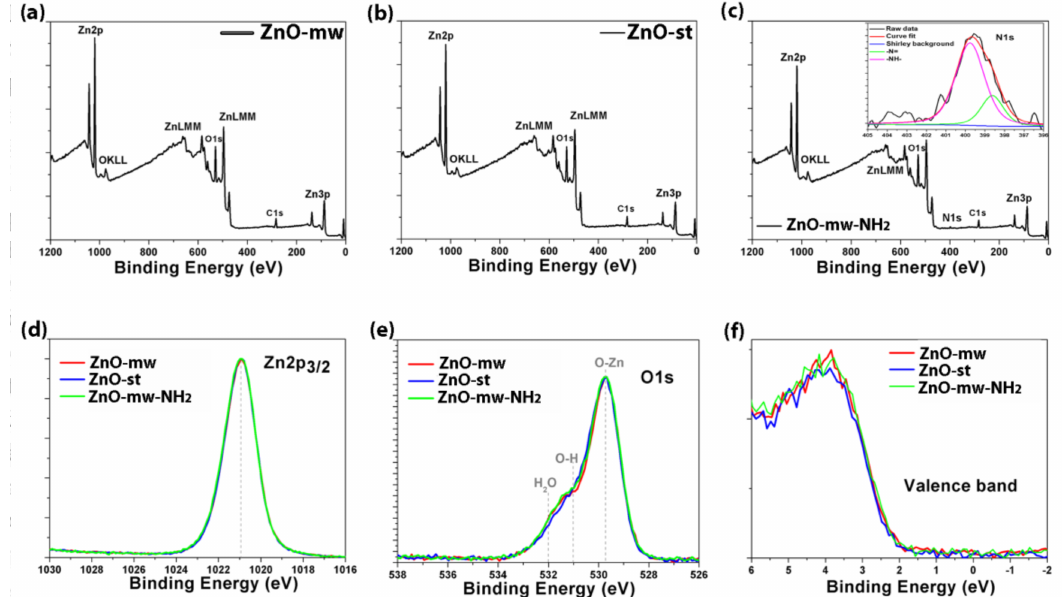
Figure 6. X-ray photoelectron spectroscopy (XPS) analysis: survey scans of ( a )